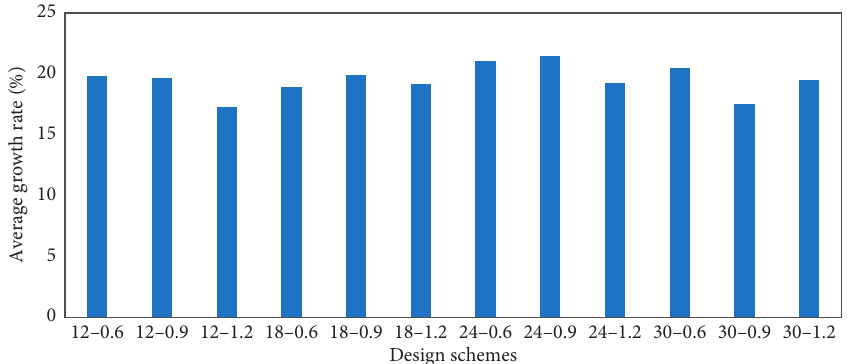
Figure 11: Trend chart of UCS average growth rate of CSM with different fiber contents.